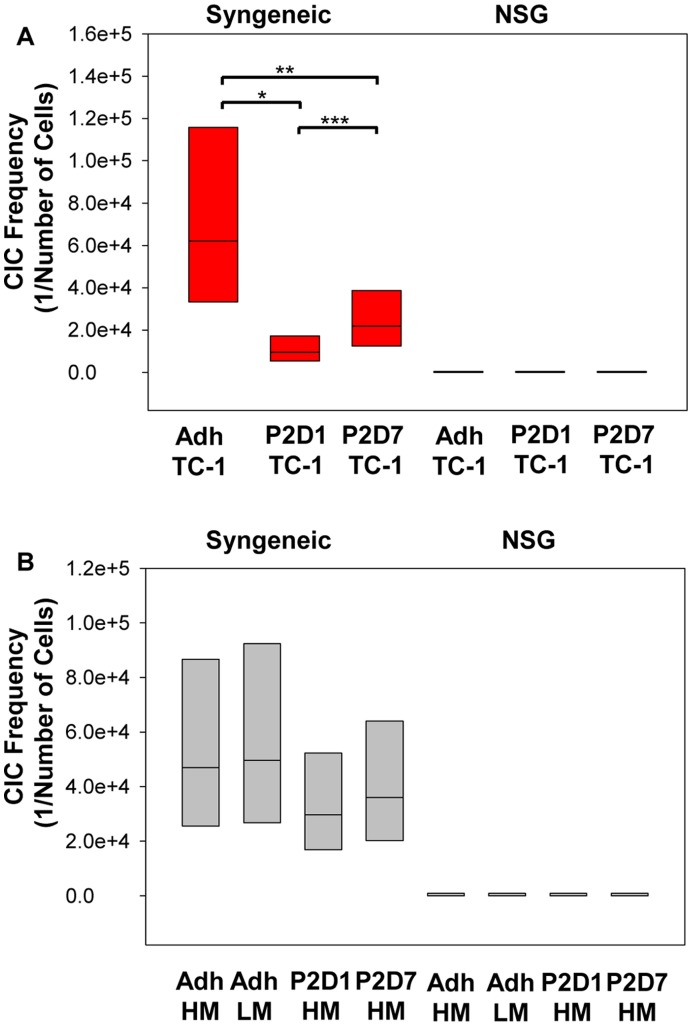

In vivo tumorigenicity of TC-1 and LLC cells in immunocompetent and immunodeficient mice.Confidence interval plot of limiting dilution analysis is shown with the y-axis displaying the estimated frequency of cancer initiating cells (CIC). (A) A limiting dilution of TC-1 cells (120,000, 80,000, 40,000, 10,000, 5,000, and 1,000) were injected subcutaneously into syngeneic C57BL/6 mice (n = 4 to 8). Sphere derived cells were found to be more tumorigenic than adherent cells; *P≤0.001; **P<0.02. Day 1 sphere-derived cells were more tumorigenic than day 7; ***P = 0.04. A limiting dilution (10,000, 1,000, and 500 cells) (n = 6 to 8) of the same three groups were injected into NSG mice and CIC frequency was found to be below 1/500 for all groups. (B) Analysis of LLC limiting dilution tumor experiment for syngeneic (80,000, 40,000, 20,000, and 10,000 cells) and immunocompromised (NSG) mice (80,000, 40,000, 10,000, and 1,000 cells) (n = 4 to 9). No significant differences noted; however, sphere-derived cells trended towards being more tumorigenic than HM or LM adherent cells in C57BL/6 mice. Lower numbers of implanted cells were needed to initiate tumors in immunocompromised animals than in syngeneic animals with the estimated CIC frequency below 1/1000 for all LLC groups.